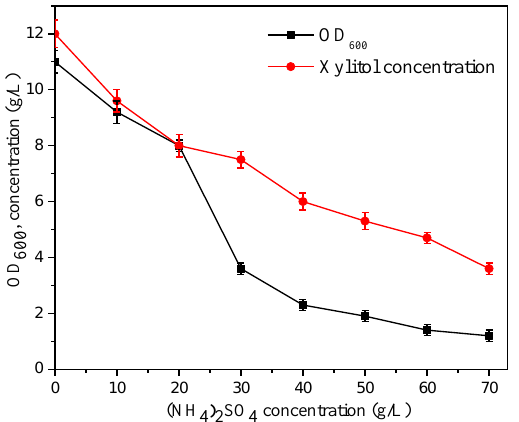
Figure 4. Effects of SO 42 − inhibition on IS5-dG strain growth and xylitol production. Individual plots are presented in Figures S6 – S8 in the Supplementary Materials. plots are presented in Figures S6–S8 in the Supplementary